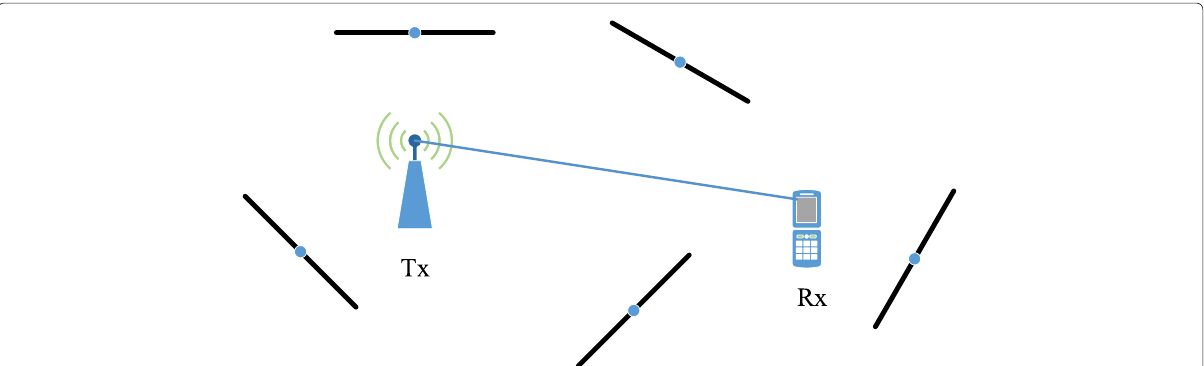
Fig. 1 Probe transmitter (Tx) and receiver (Rx) in the presence of randomly distributed environmental